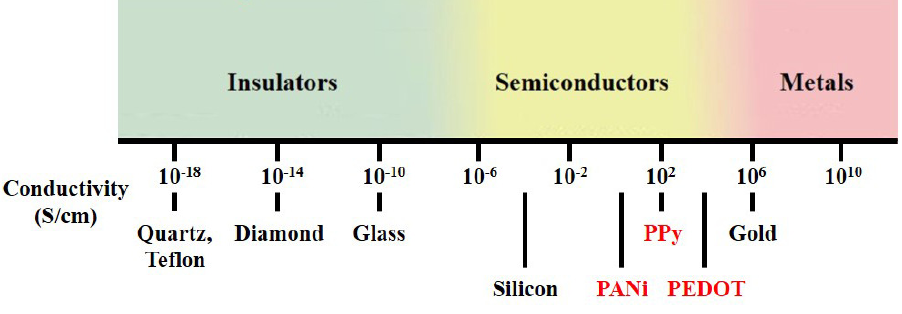
Figure 1. Conductivity range of conducting polymer.